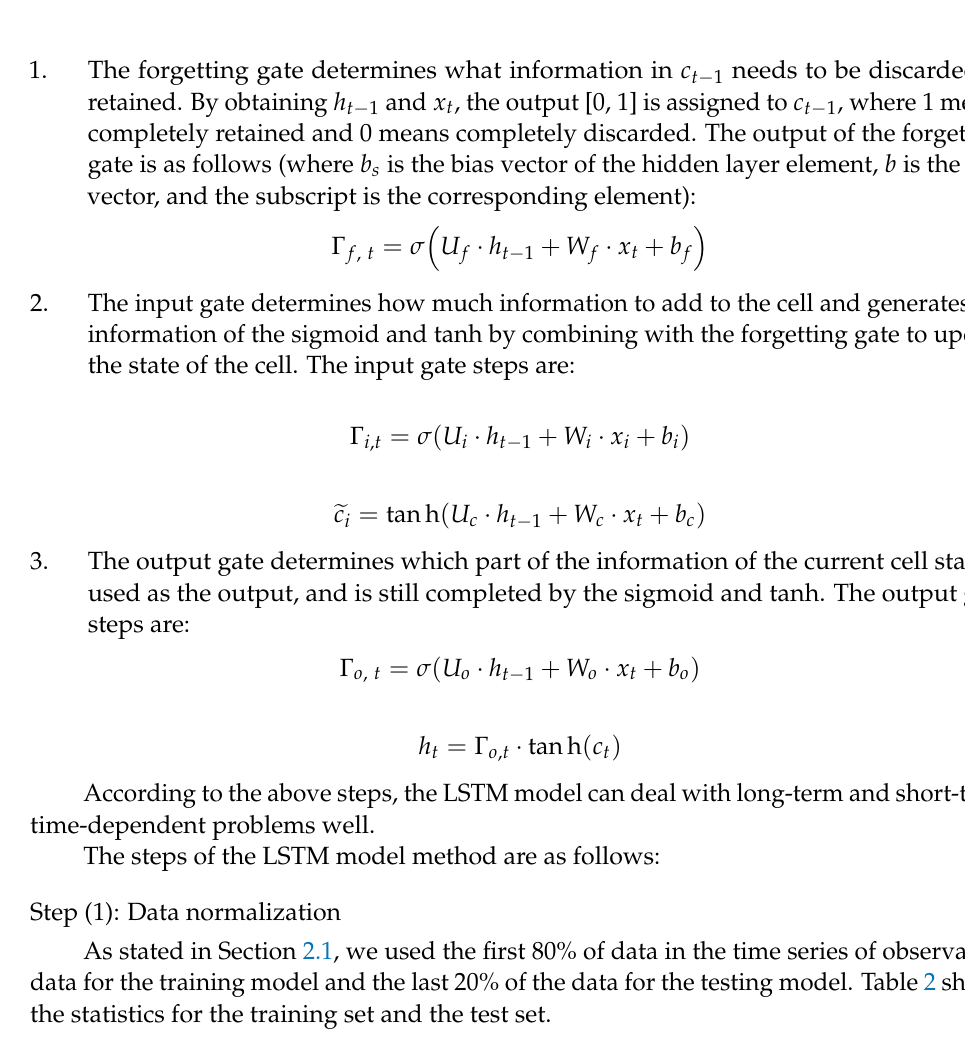
Table 2. The statistical wind speed information for the dataset from Yanqing station and Zhaitang station.